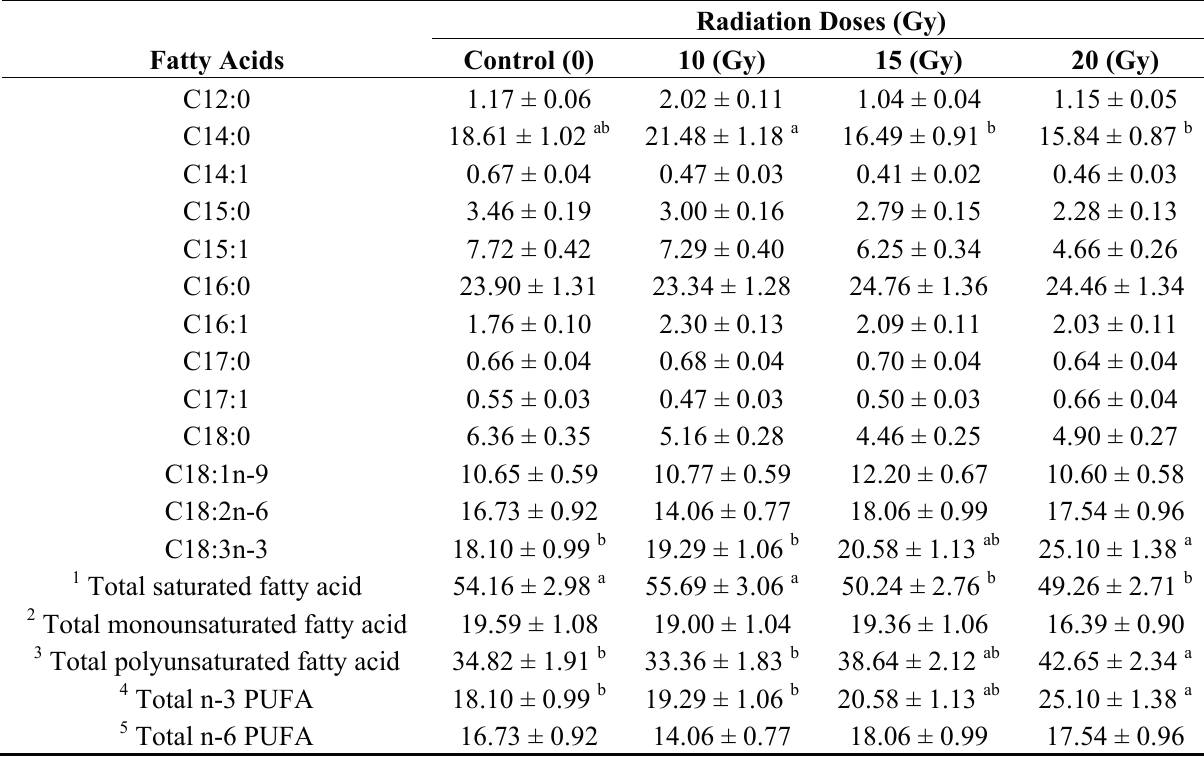
Table 4. Leaves Fatty acid composition of C. alismatifolia var. Sweet Pink under different dose levels of acute gamma irradiation (Mean ± SEM; n =